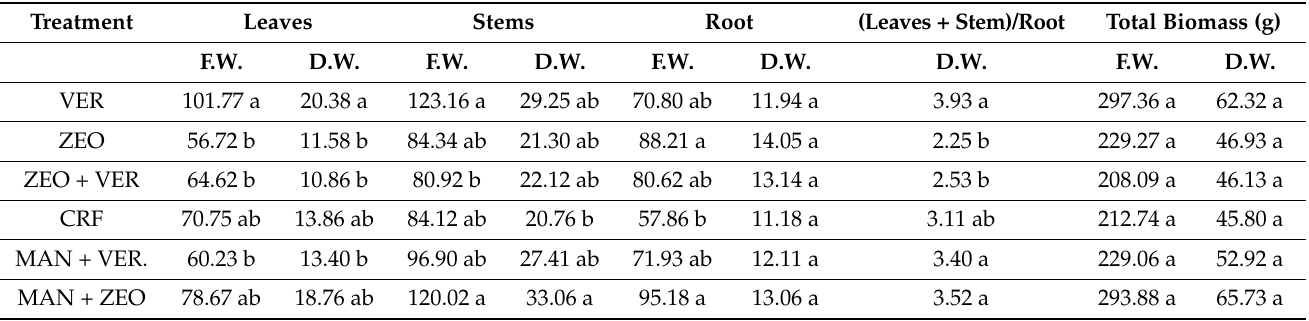
Table 1. Fresh weight (F.W.) and dry weight (D.W.) of the different plant tissues (leaves, stems and root) of pepper plants among the treatments.